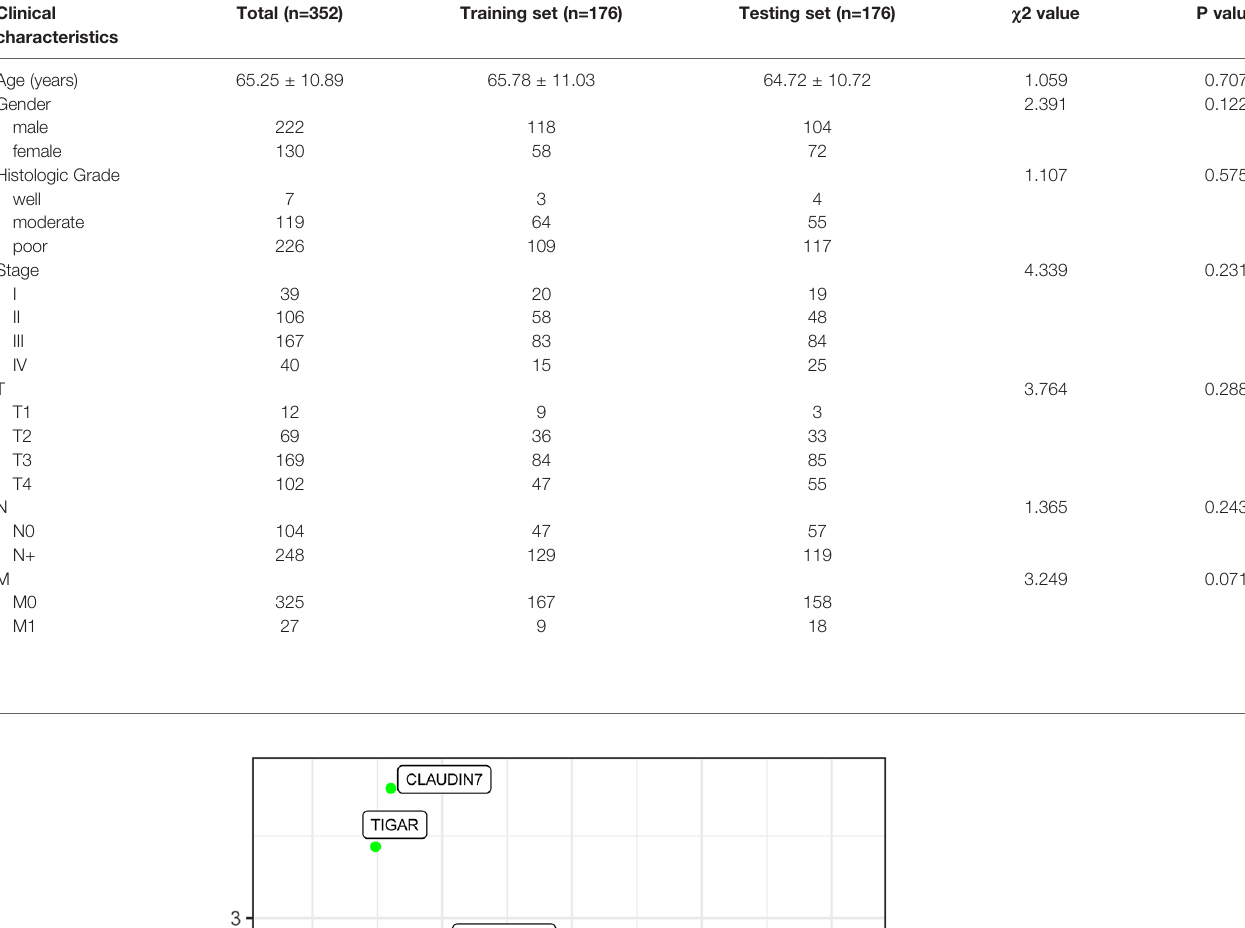
TABLE 1 | Clinicopathological data for the training and testing